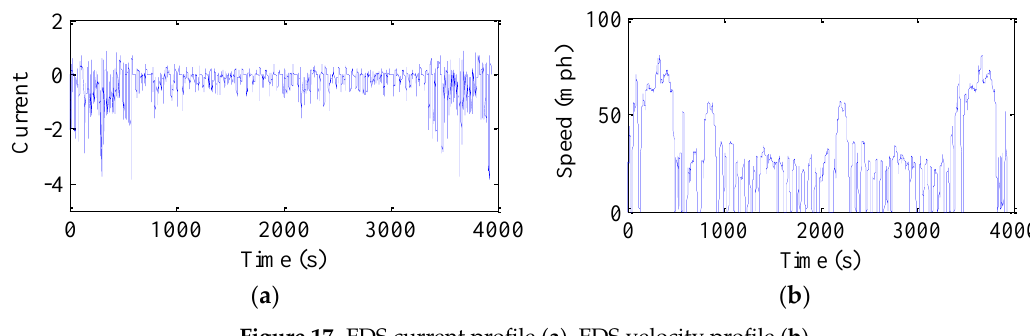
Figure 17. FDS current profile ( a ), FDS velocity profile ( b ).